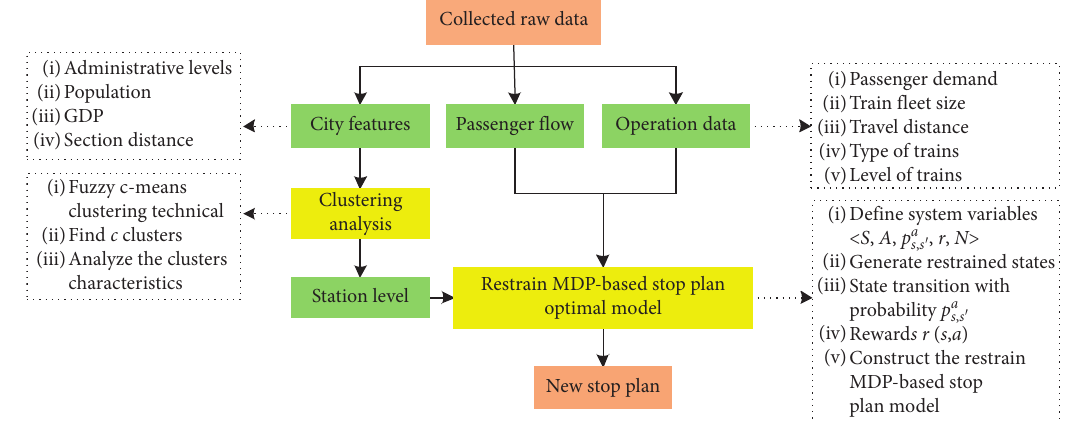
Figure 1: Framework for the stop